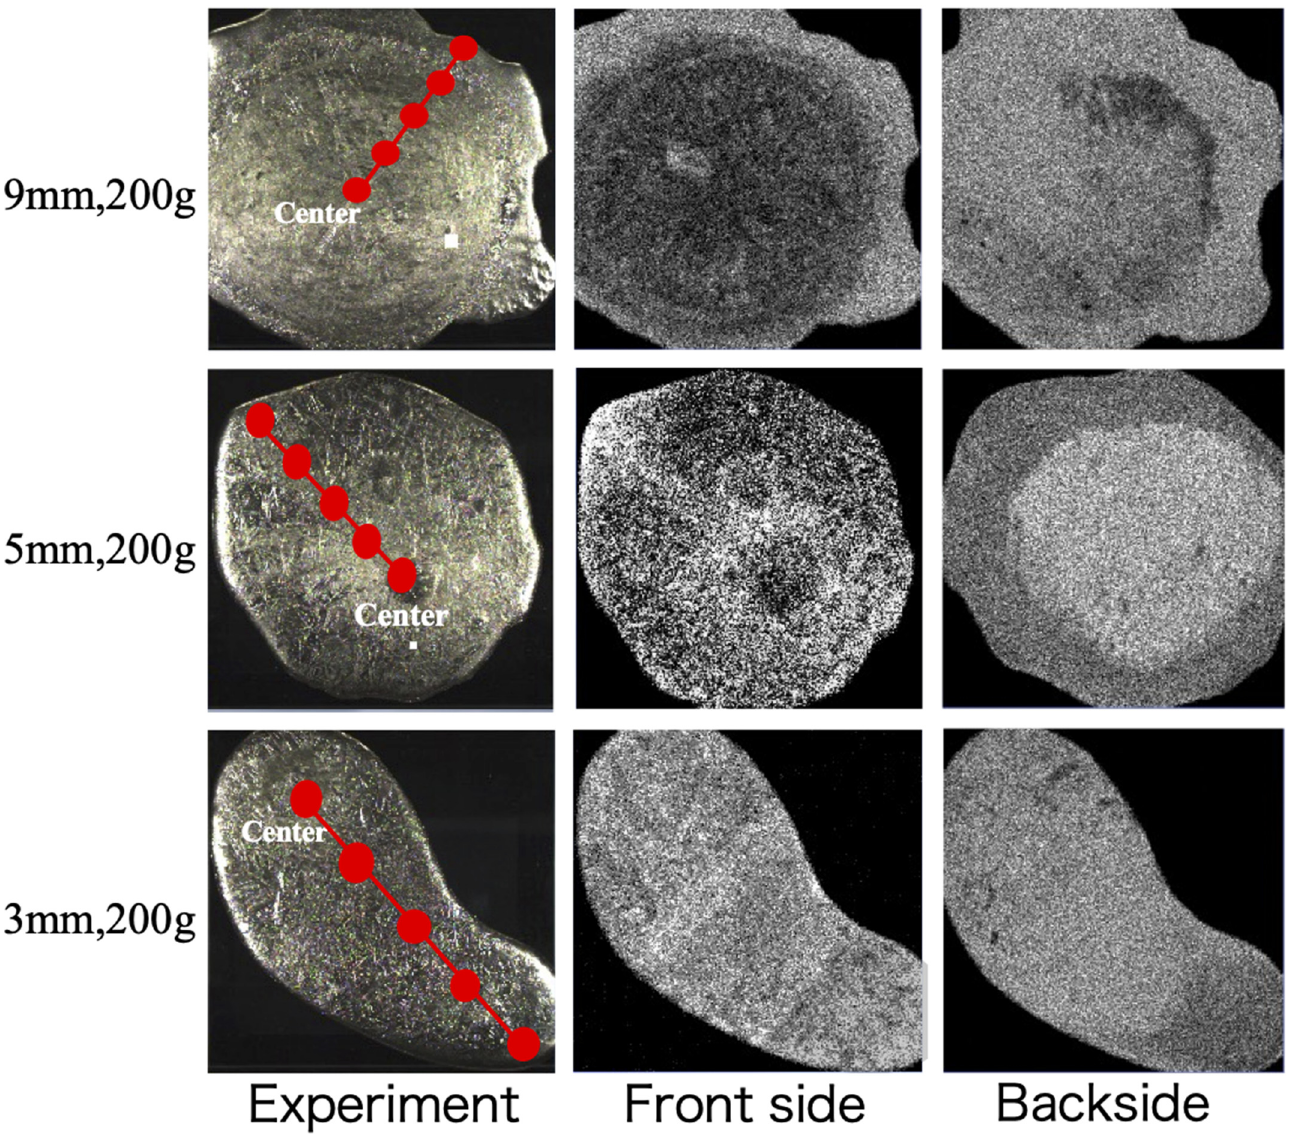
Figure 7. Mapping image analysis results in the reverse density stratification. The point analysis results on the Pb distribution under the reverse density stratification condition are shown in Figure 8. For large outlets, i.e., 9 mm and 7 mm, larger amounts of Pb tended to be observed at the edge. In contrast, for small outlets, i.e., 5 mm and 3 mm, the Pb distribution was detected near the centre. These findings signified that the outlet difference affected the eventual material